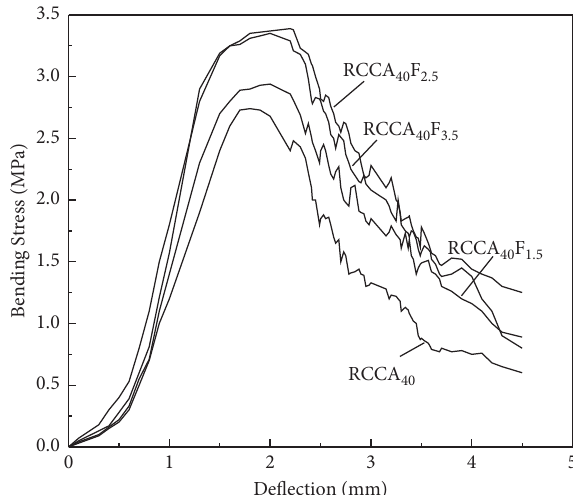
Figure 12: Stress-deflection curves RCCA RCCA 40 F 2.5 , and RCCA 40 F 3.5 .